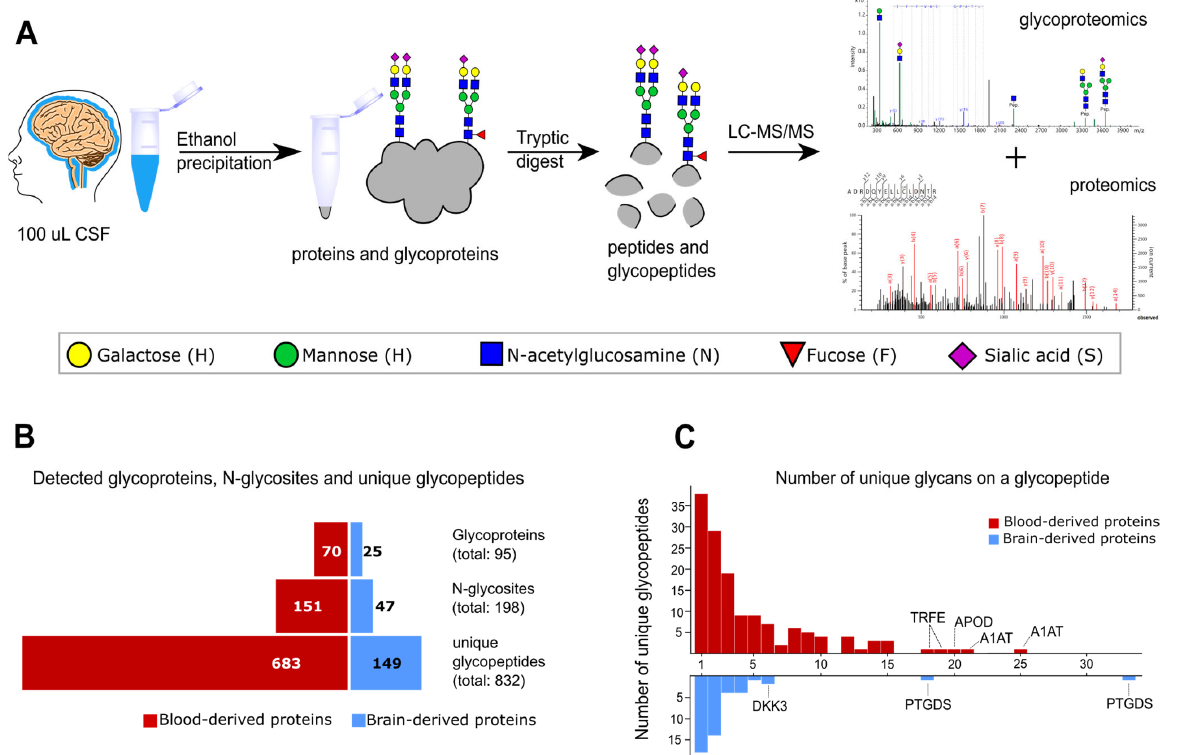
Figure 1. Glycoproteomics workflow. ( A ) In total, 100 μ L of CSF was collected from CDG patients and healthy controls. Proteins and glycoproteins were enriched by protein precipitation with ice- cold ethanol. After resuspension and tryptic digest, peptides and glycopeptides were analyzed by LC-MS/MS. The glycoproteomics data were interpreted using MSFragger Glyco. ( B ) Although our workflow does not include any glycopeptide enrichment, we were able to detect over 800 unique glycopeptides from 198 different N-glycosites originating from 95 different glycoproteins. Around 20% of detected unique glycopeptides, N-glycosites, and glycoproteins originate from purely brain- derived proteins. ( C ) Glycosite heterogeneity on detected N-glycosites is visualized for blood-derived and brain-derived proteins. For most N-glycosites, one or two unique glycans were detected. Some glycosites show a variety of different glycan structures, as seen on N-glycosylation sites of transferrin (TRFE), alpha-1-antitrypsin (A1AT), apolipoprotein D (APOD) or brain-derived prostaglandin-H2 D-isomerase (PTGDS), and dickkopf-related protein 3